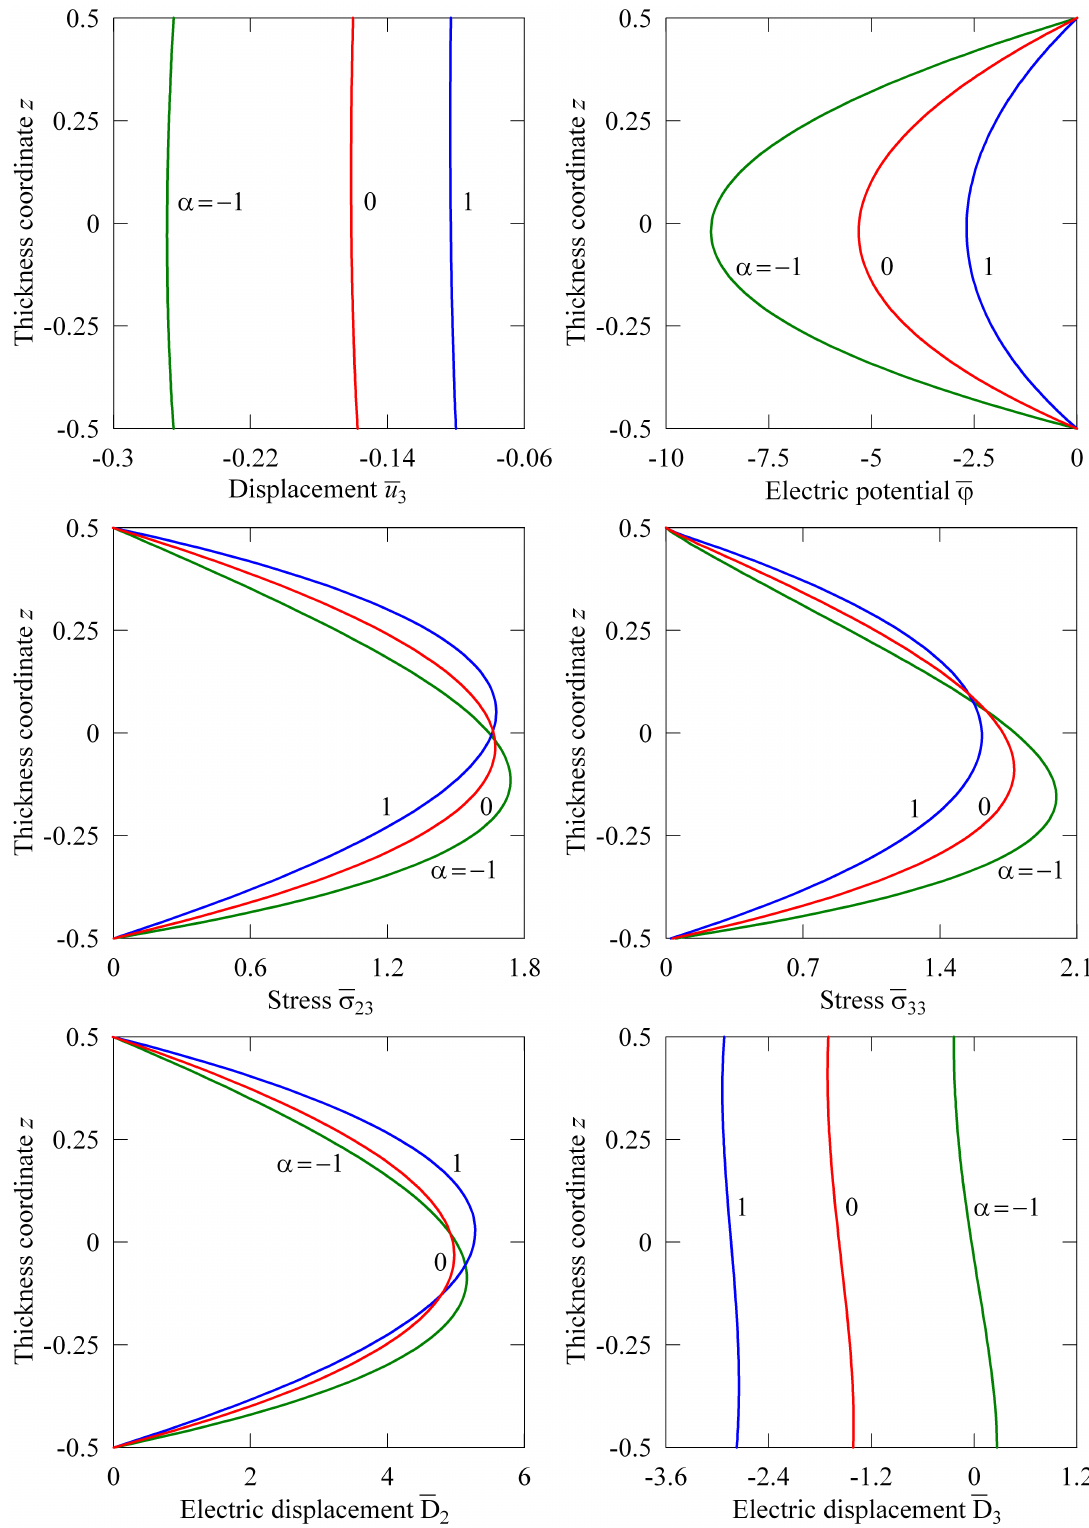
Figure 14: Through-thickness distributions of the transverse displacement, stresses, electric potential and electric displacement for a thick cylindrical shell using nine